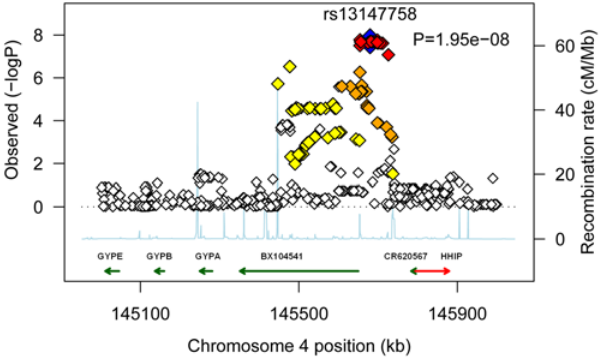
Figure 2. Plot of chromosome 4 association with percent predicted FEV 1 /FVC in imputed Framingham Heart Study data. X-axis is the physical position in kb with arrows denoting genes and expressed sequence tags in the region, the left y-axis plots the 2 log(p- value), and the right y-axis plots the CEPH recombination rate. The blue diamond identifies the labeled SNP of interest, and LD with the SNP is depicted by color of additional diamonds: red-strong LD (r 2 $ 0.8), orange-moderate LD (0.5 # r 2 , 0.8), yellow-low LD (0.2 # r 2 , 0.5), white- no LD (r 2 , 0.2).